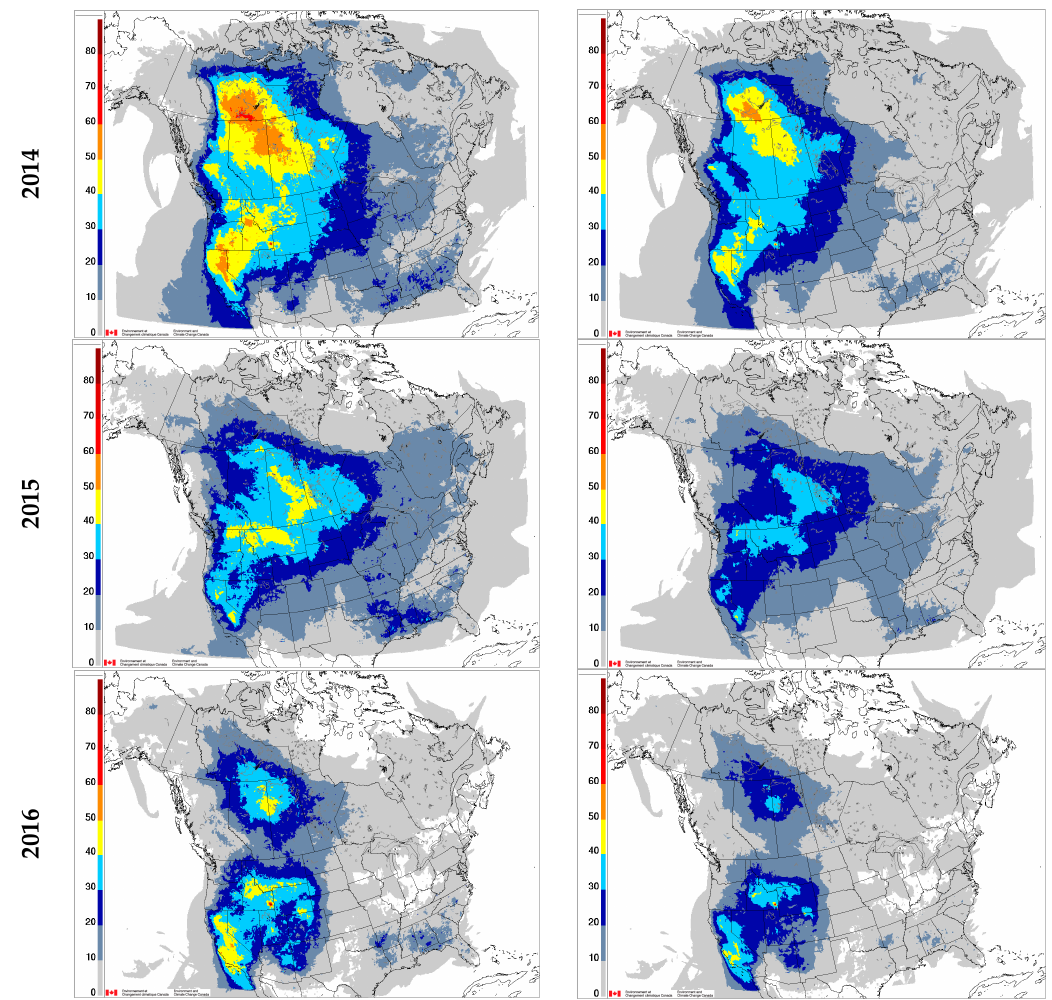
Figure 9. Percentage frequency of the number of days ( left ) and the number of hours ( right ) with forecasted 24-h moving average PM 2.5 concentration above 1 µg/m 3 from fire-PM 2.5 contribution for the period May–September for years 2013, 2014, 2015, and 2016. White areas indicate locations that experienced no days or hours above the threshold during the period.